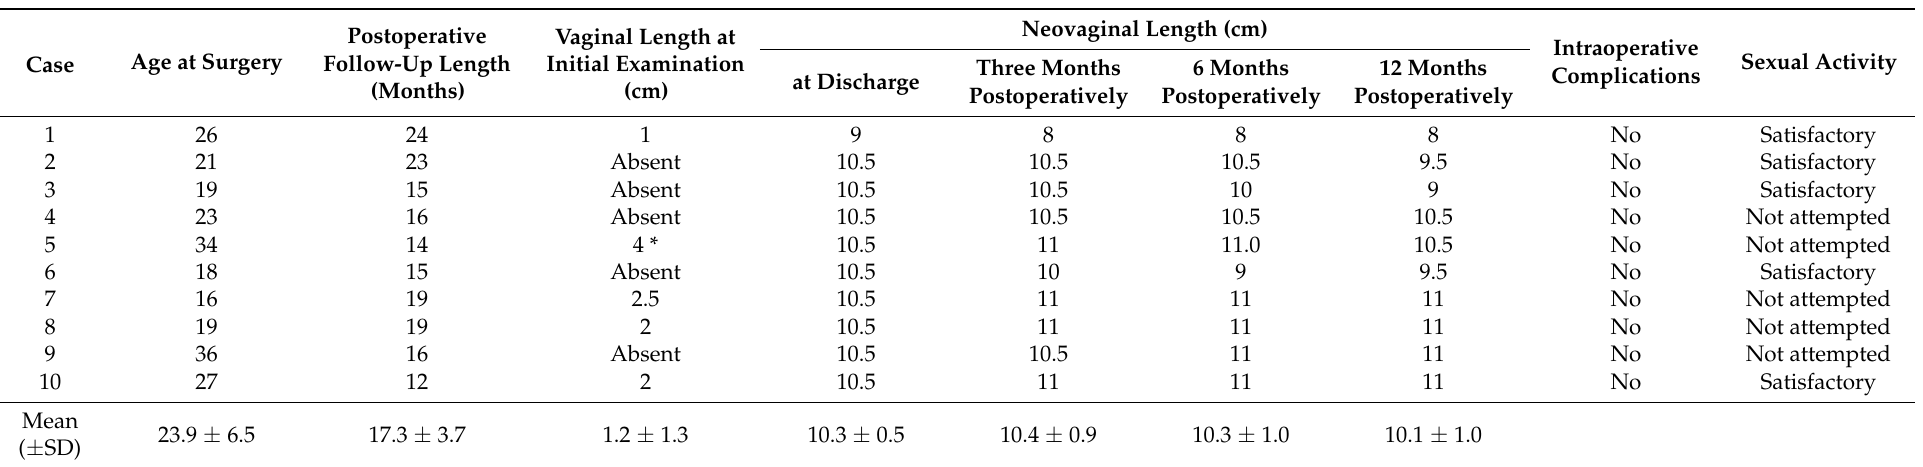
Table 1. Postoperative outcomes of vaginoplasty in